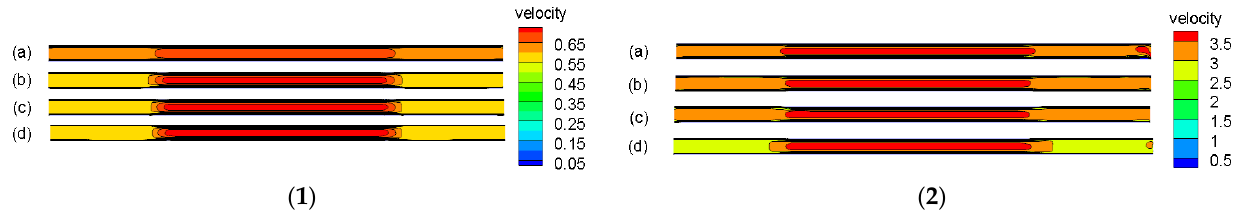
Figure 12. Velocity contours and velocity contour distribution in damping channel when the current is 0.5 A, 1 A, 1.5 A and 2 A at different velocities. ( 1 ) velocity = 0.1 m/s; ( 2 ) velocity = 0.5 m/s. (a) the current is 0.5 A; (b) the current is 1 A; (c) the current is 1.5 A; (d) the current is 2 A.